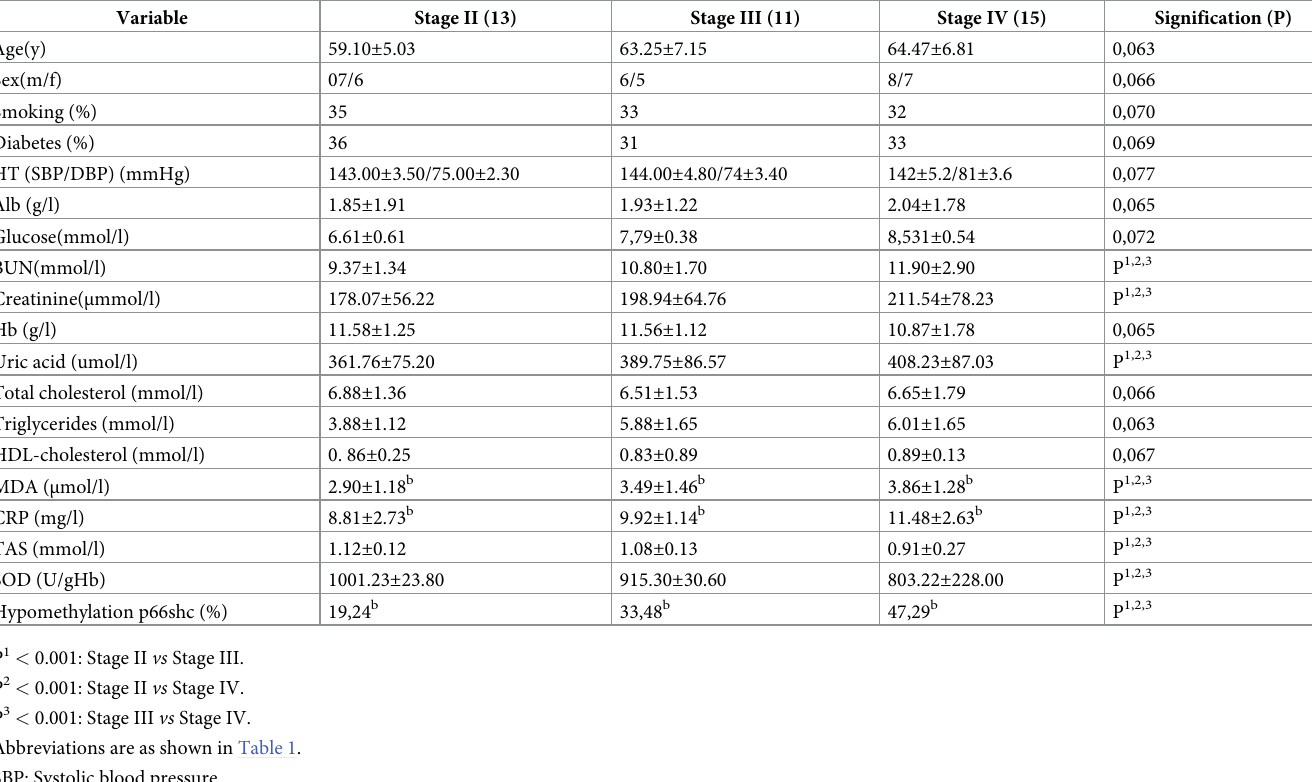
Table 2. Clinical characteristics, renal function, inflammatory and oxidative stress, and DNA methylation markers levels according to CRF